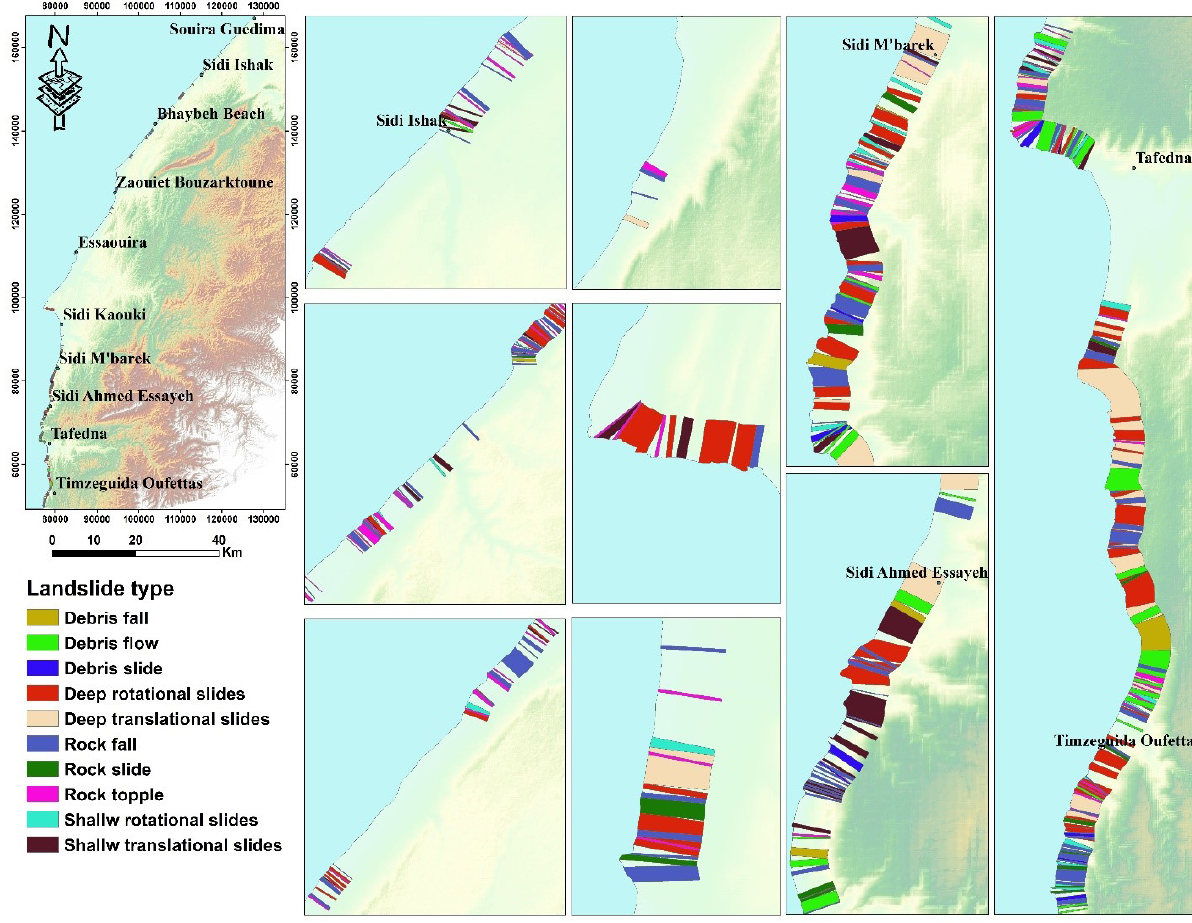
Figure 5. Spatial distribution of landslide types in the study